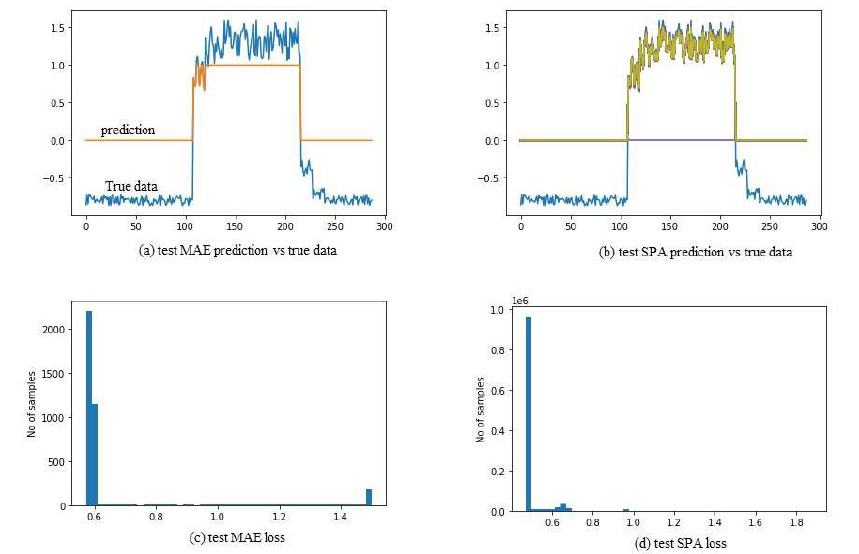
Figure 4. Results for the fully connected AE. Plots ( a , b ) show the true vs. predicted values for MAE and SPA loss functions, respectively. Plots ( c , d ) show the test loss for MAE and SPA loss functions,